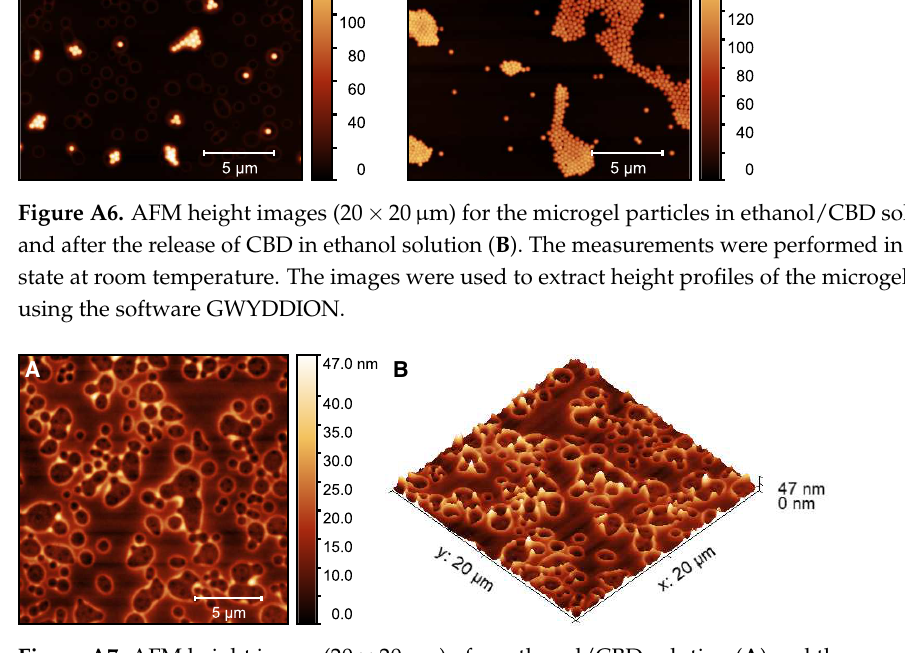
Figure A7. AFM height image (20 × 20 µ m) of an ethanol/CBD solution ( A ) and the corresponding 3D image ( B ). The measurements were performed in the dried state at room temperature.